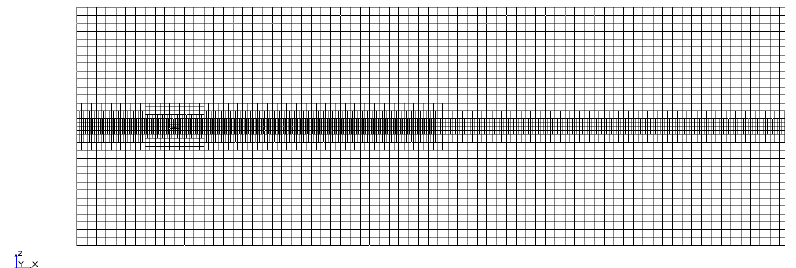
Figure 3. Computational domain.